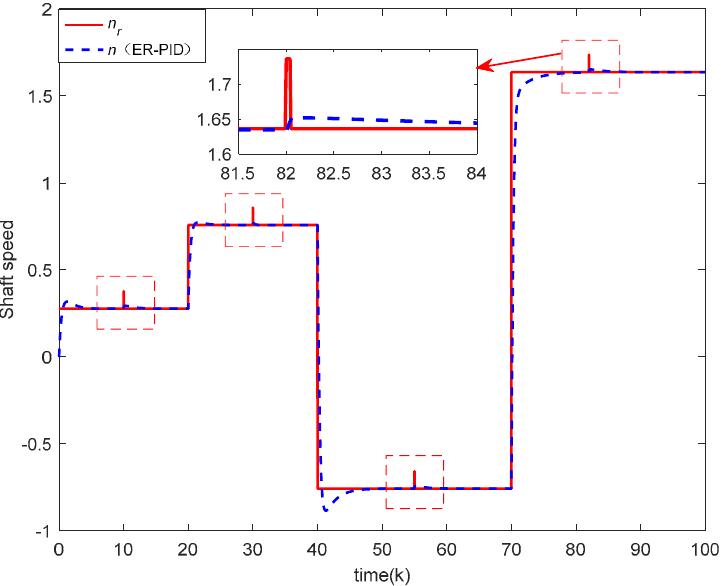
Figure 11. Tracking results of the ER-PID controller with a multi-point perturbation.